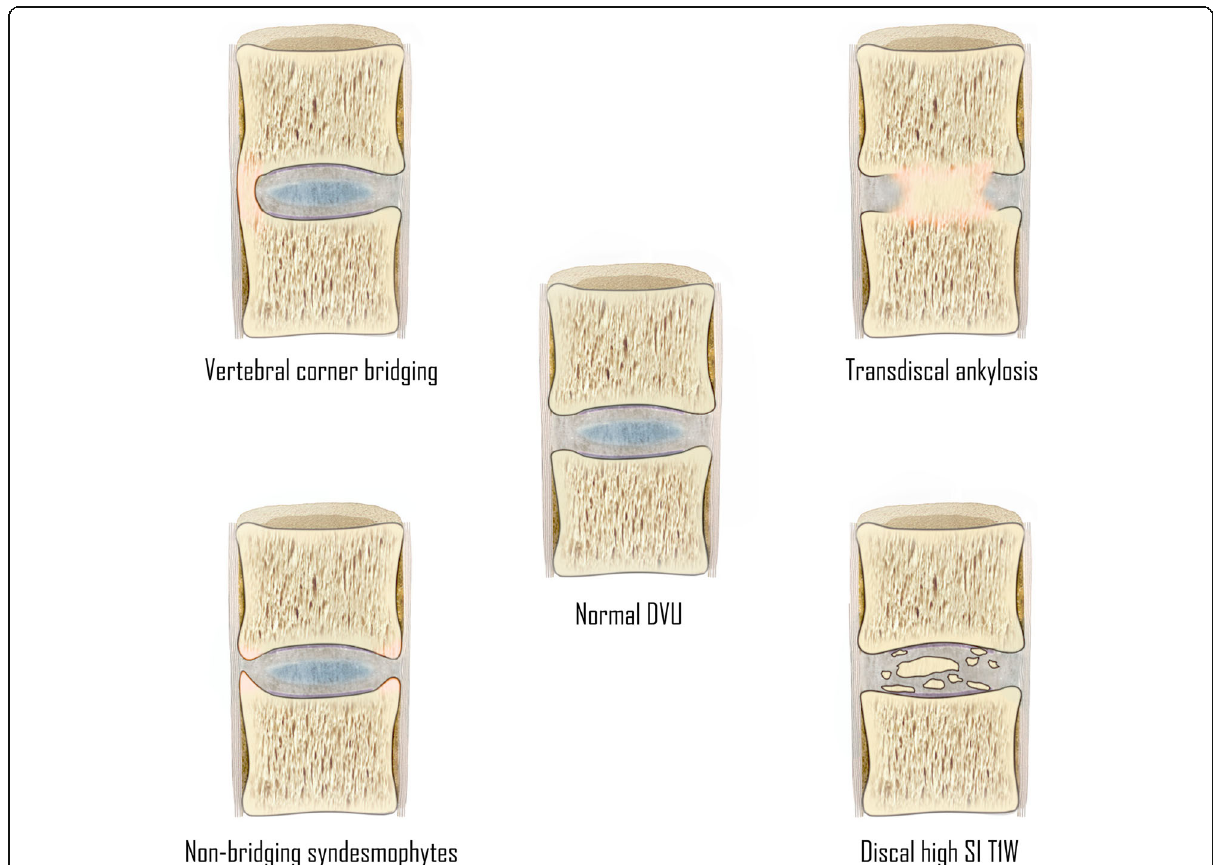
Fig. 4 Features associated with new bone formation at the disco-vertebral unit of patients with SpA. (DVU = disco-vertebral unit; SI T1W = signal intensity on T1-weighted MR